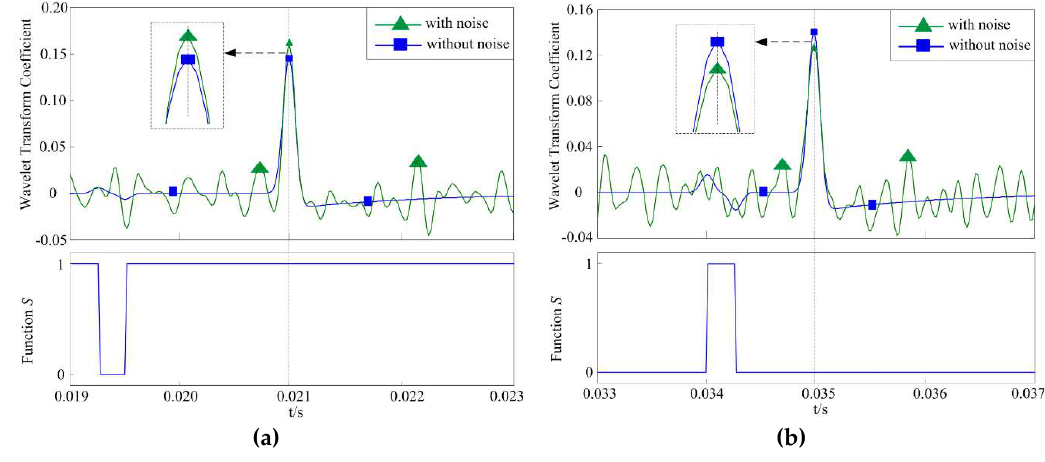
Figure 12. Faulty IGBT location under scale 4: ( a ) Case 1; ( b ) Case